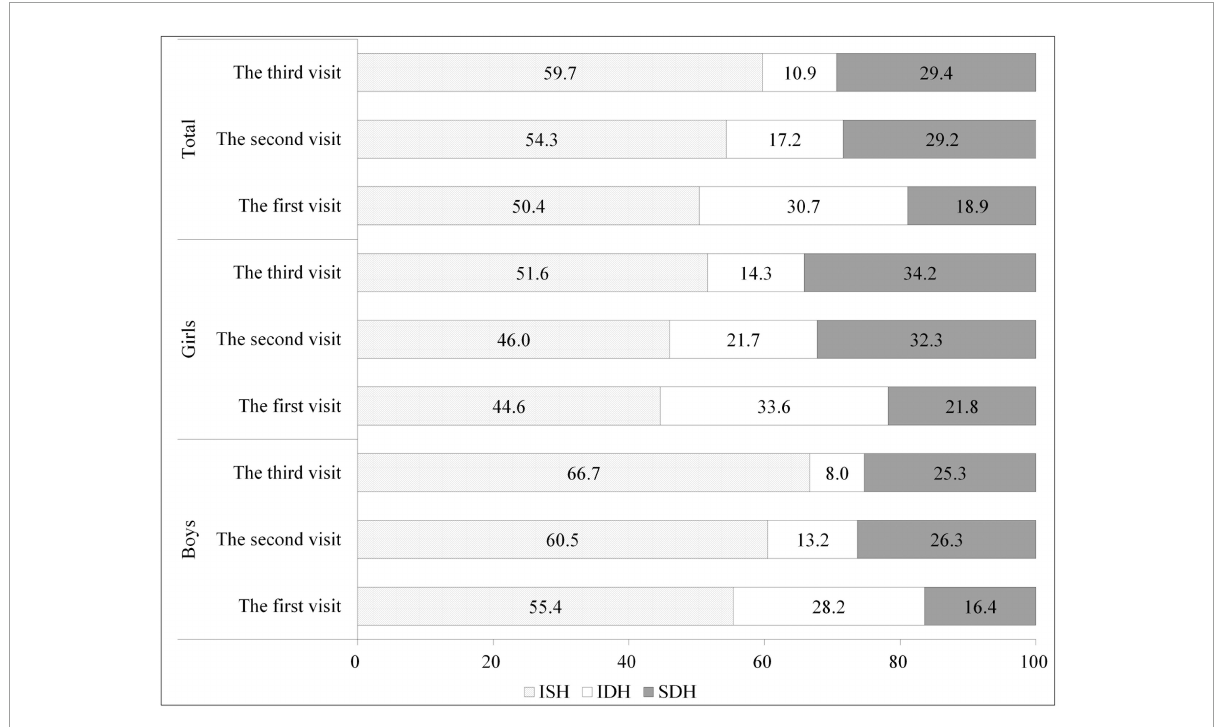
FIGURE2 Proportions of hypertension phenotypes at three visits by gender group.